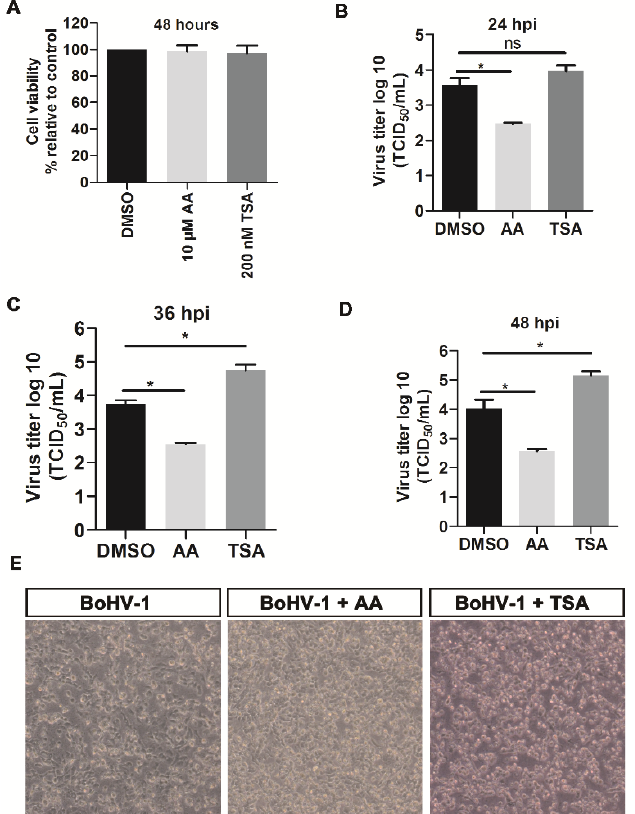
Figure 3. The effects of HDAC inhibitor TSA had on BoHV-1 productive infection in A549 cells. ( A ) A549 cells were treated with DMSO vehicle control, AA (10 µ M) and TSA (200 nM) for 48 h, respectively, then the cytotoxicity of individual chemical on the cell culture was determined using Trypan-blue exclusion test. ( B ) A549 cells pretreated with either DMSO vehicle control or HATs inhibitor AA (10 μ M), and HDACs inhibitor TSA (200 nM) for 2 h, were infected with BoHV-1 (MOI = 0.1) along with treatment of either AA (10 μ M) or TSA (200 nM) for 3 h, then fresh medium containing indicated chemicals were replaced after washing three times. After infection for 24 h ( B ), 36 h ( C ) and 48 h ( D ), the virus productions were determined in MDBK cells, with result expressed as TCID50/mL. Data shown are means ± SD of three independent experiments. Statistical analyses were performed using Student’s t -test (* p < 0.05). ns, not significant. ( E ) After infection for 48 h, the cell morphology was observed under a light microscope. Data shown are represents of three independent experiments.